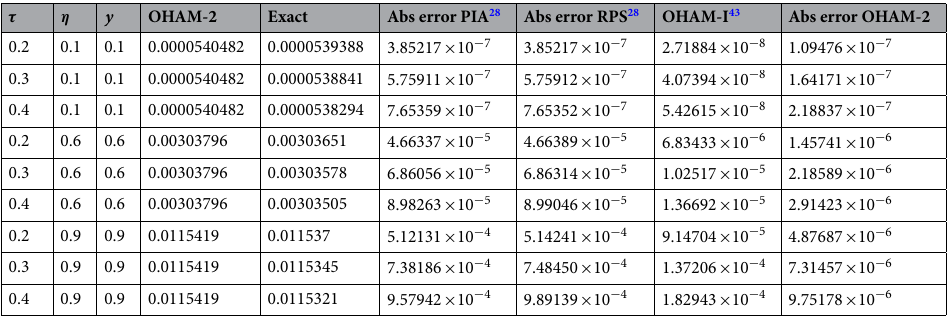
Table 4. Comparison of absolute errors obtained by the OHAM-2 and PIA and RPS methods when α = 1.0 and (cid:31) = 0.001 for